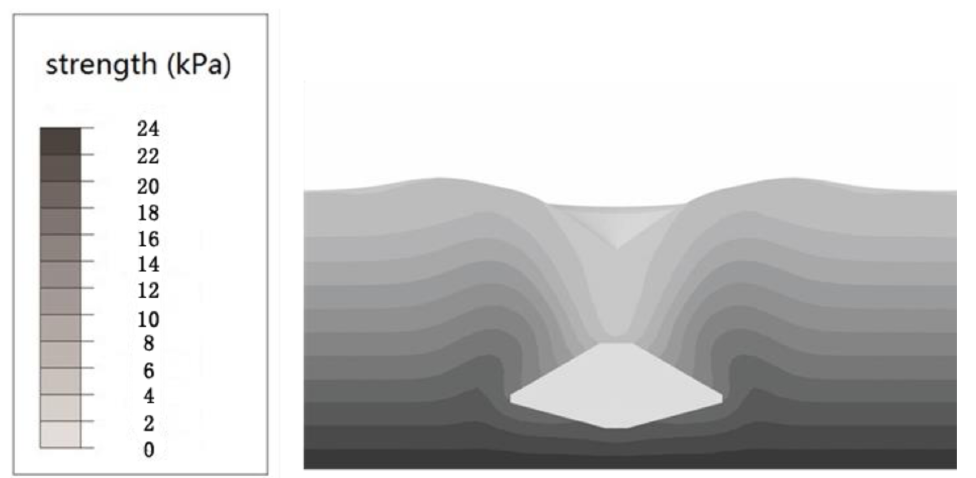
Figure 5. Initial strength field of the small-strain Lagrangian